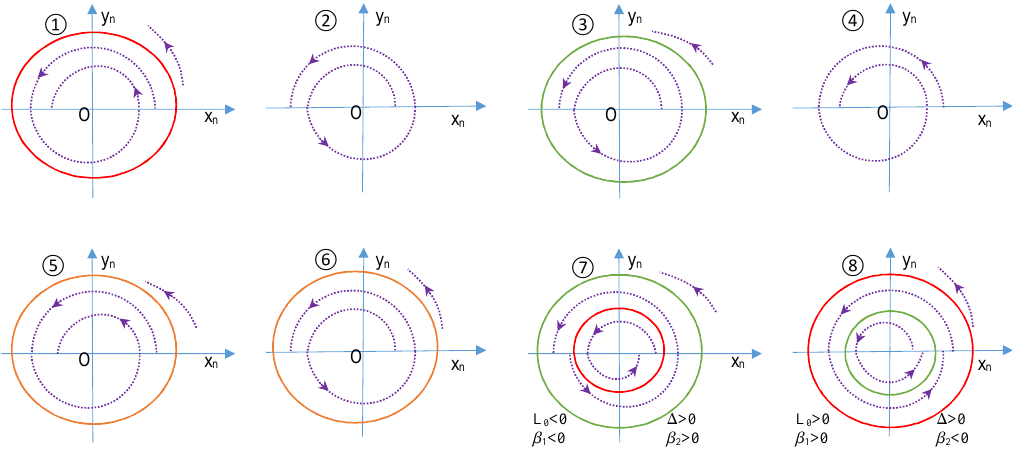
Figure A1. Generic portraits phase when θ 0 >